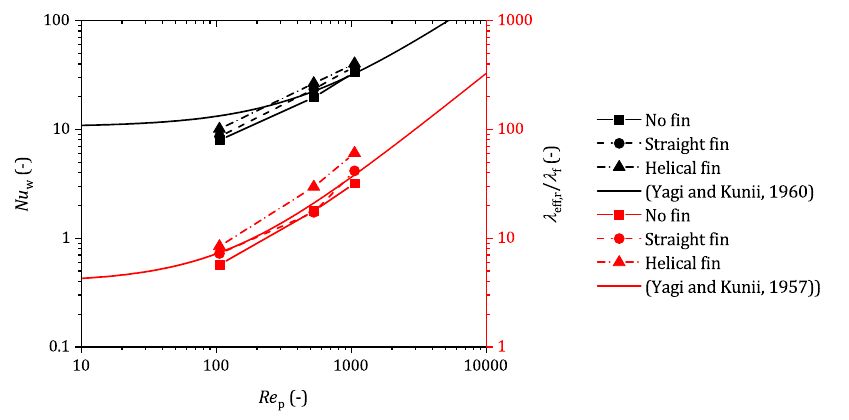
Figure 13. Wall Nusselt number (black) and the dimensionless effective radial thermal conductivity (red) as a function of particle Reynolds number for all investigated designs in comparison to the correlations of Yagi and Kunii